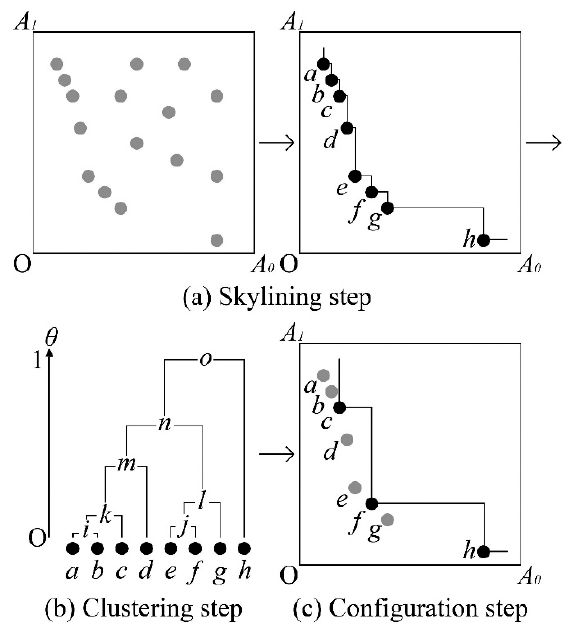
Figure 3. Overall process of RSC.